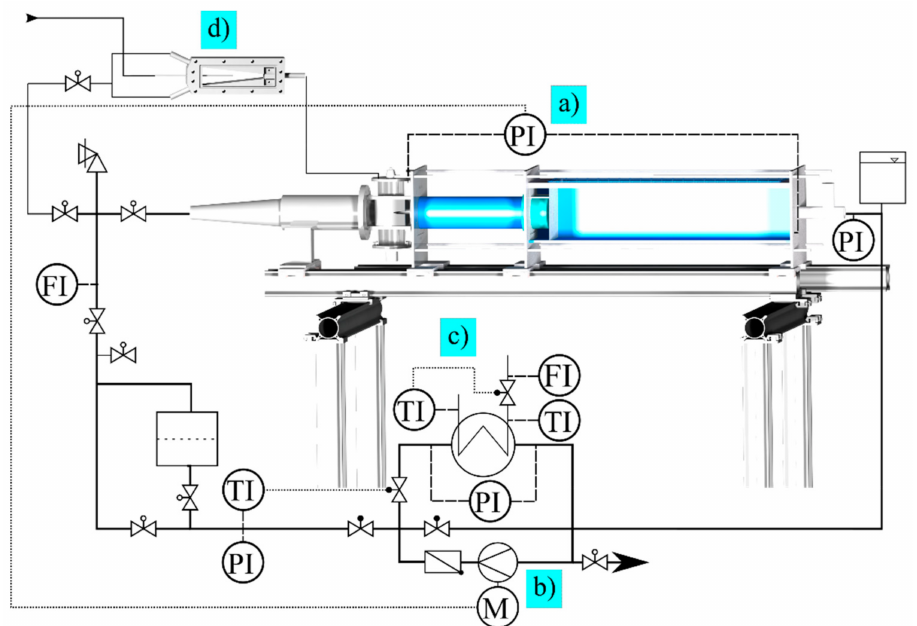
Figure 2. Flow diagram of the macro scale experimental setup: ( a ) measurement section, ( b ) centrifu- gal pump, ( c ) heat exchanger, ( d ) droplet production